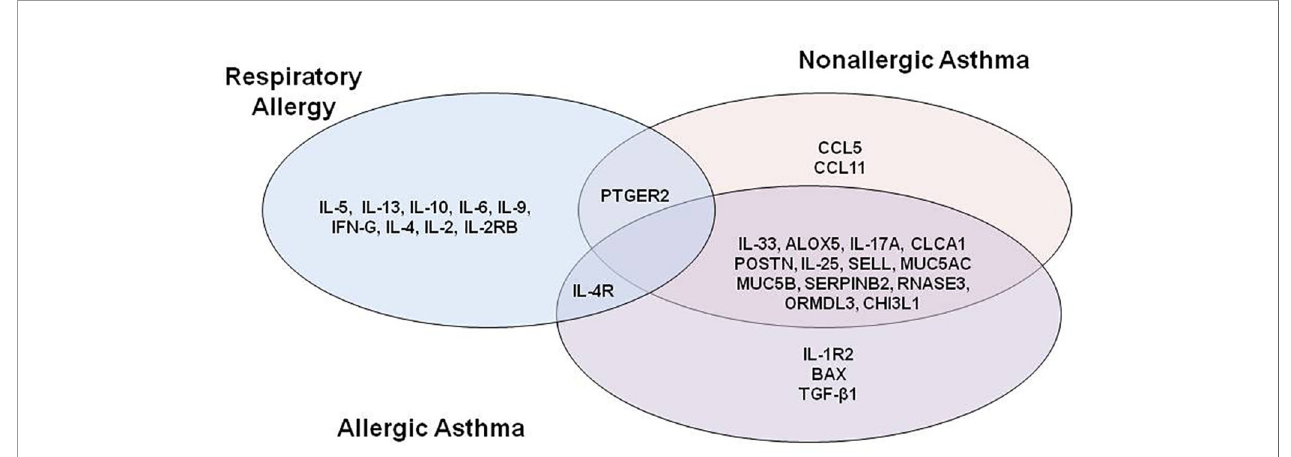
FIGURE 2 | Venn diagram of proteins with “ high ” or stronger relationship level with at least one disease.